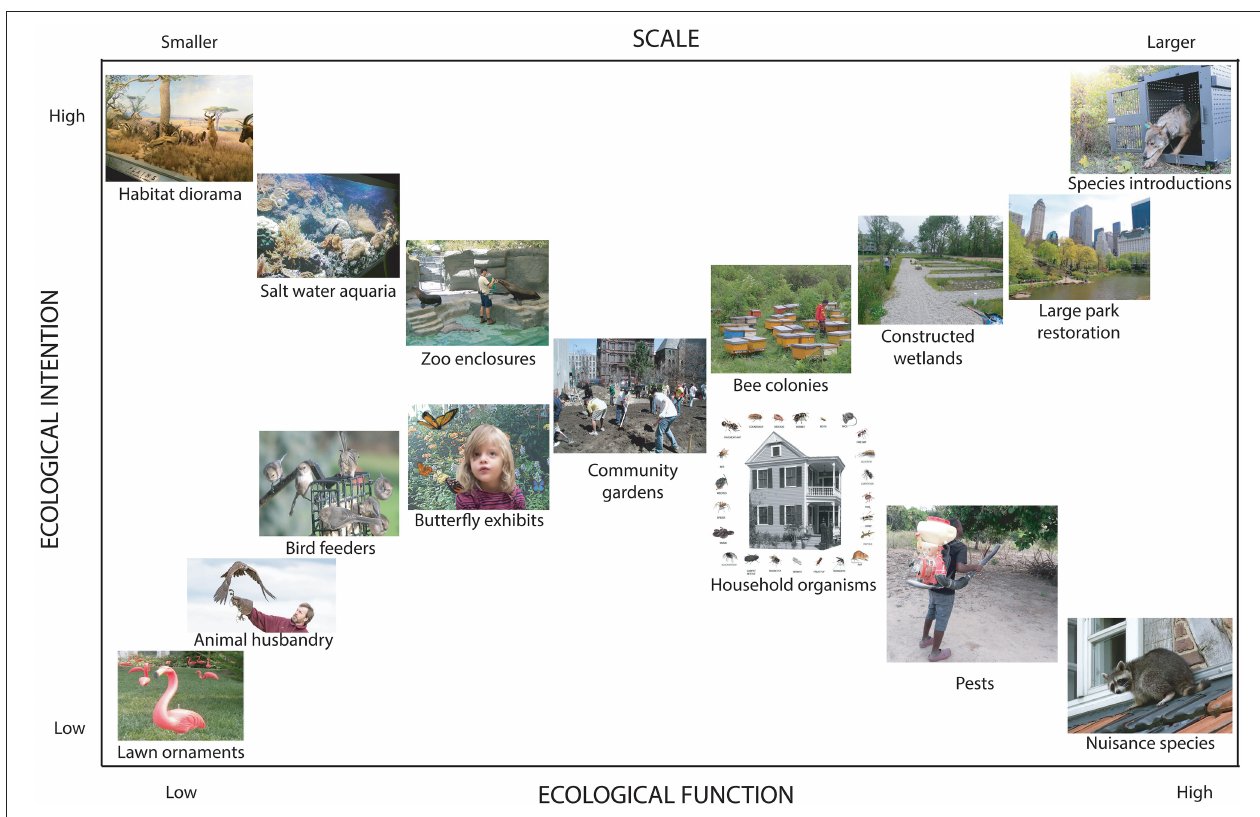
FIGURE 2 | Constructed urban food webs are an outcome of both intentional and unintentional human activities and come in many shapes and sizes. This figure illustrates relationships between ecological functions and human intention to modify the local ecology in real and representational food webs. For designed food webs, we need to combine intentionality with theories of biological succession, invasion, species interactions, and other ecological applications to evaluate and manage the systems over time. Image sources: Lawn ornaments (Bert bert: https://commons.wikimedia.org/wiki/File:Flamingo_1.jpg; CC-BY); Animal husbandry (Government of Victoria: https://www.yarracity.vic.gov.au/events/2018/06/02/hawk-owl-falconry-display; public domain); Bird feeders (Scott Catron: https://commons.wikimedia.org/ w/index.php?curid=849195; CC-BY-2.5); Butterfly exhibits (Alexander Felson: photomontage, 2020; used with permission); Community gardens (Alexander Felson: photograph, 2005; used with permission); Habitat diorama (NComparato: https://commons.wikimedia.org/wiki/File:Plains_Diorama.JPG; CC-BY-SA 3.0); Salt water aquaria (Fritz Geller-Grimm; https://commons.wikimedia.org/wiki/File:Aquarium_fg01.jpg; CC-BY-SA-2.5); Zoo enclosures (Fir0002: https://commons.wikimedia.org/ wiki/File:Seals@melb_zoo.jpg; CC-BY-SA-3.0); Bee colonies (Okkisafire: http://self.gutenberg.org/articles/eng/File:Beekeeping_at_Kawah_Ijen,_Indonesia.jpg; CC-BY-SA 3.0); Constructed wetlands (Alexander Felson: photograph, 2020; used with permission); Large park restoration (Ingfbruno: https://commons.wikimedia.